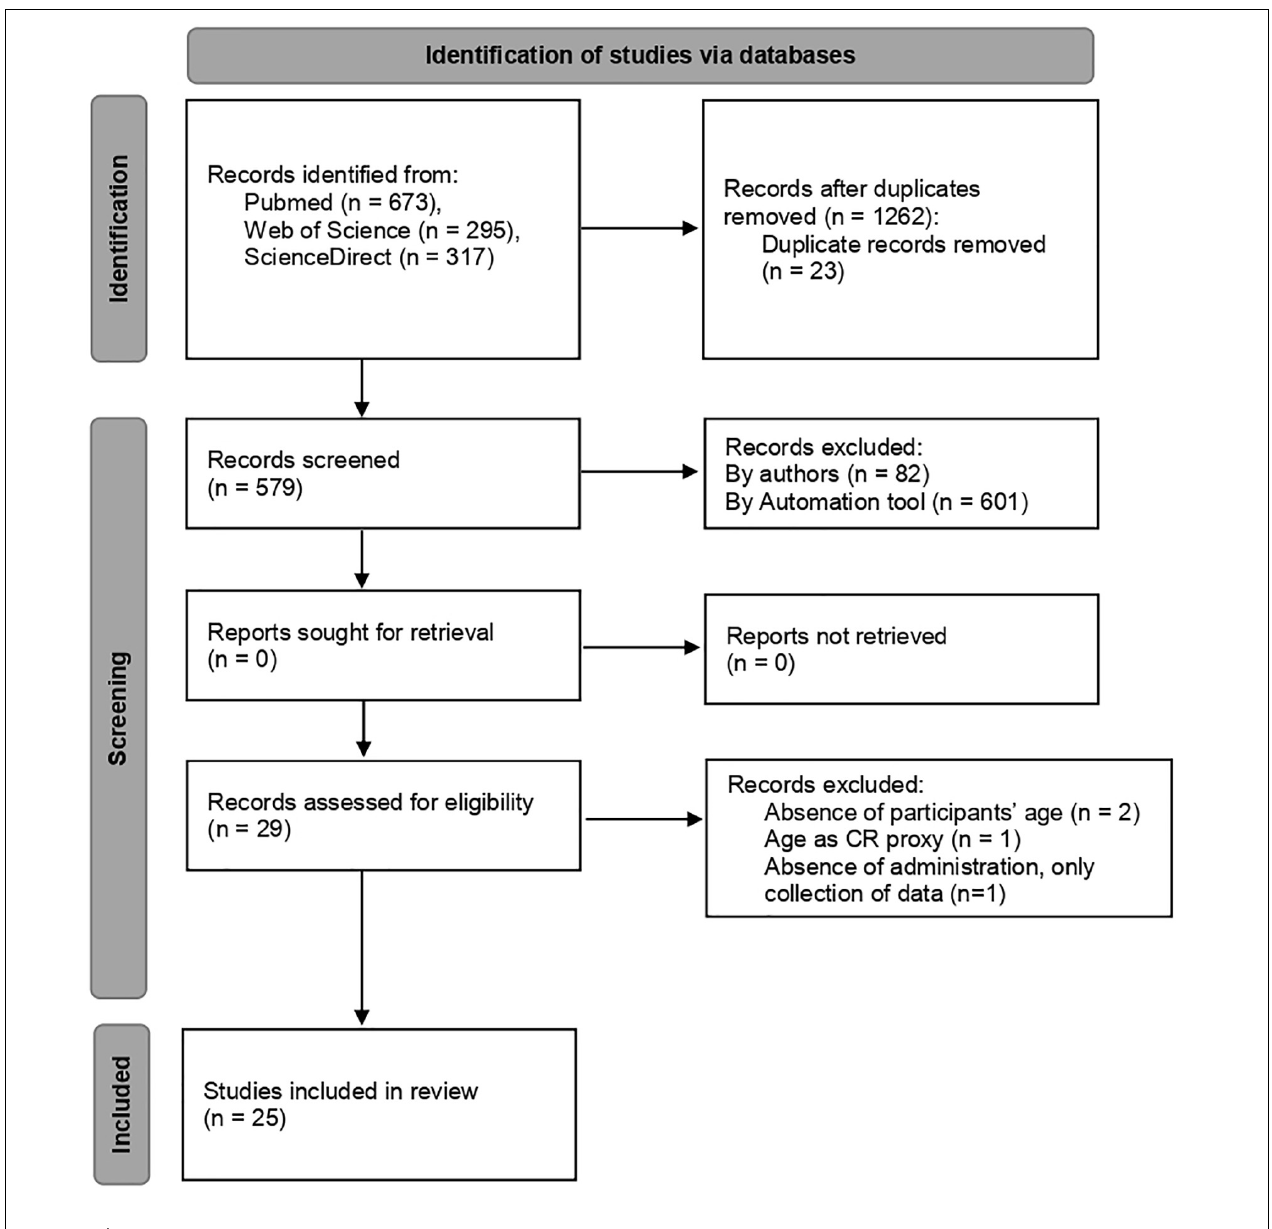
FIGURE 1 | Flowchart of literature